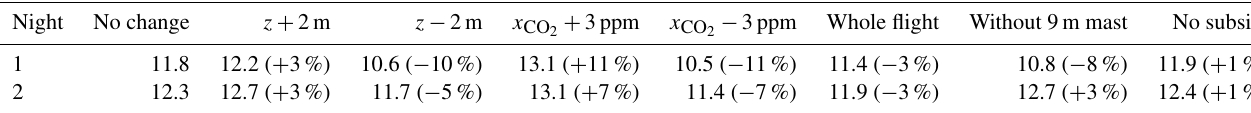
Table 5. Sensitivity of CO 2 flux to different factors (see text for details). Fluxes are in micromoles per square metre per second.